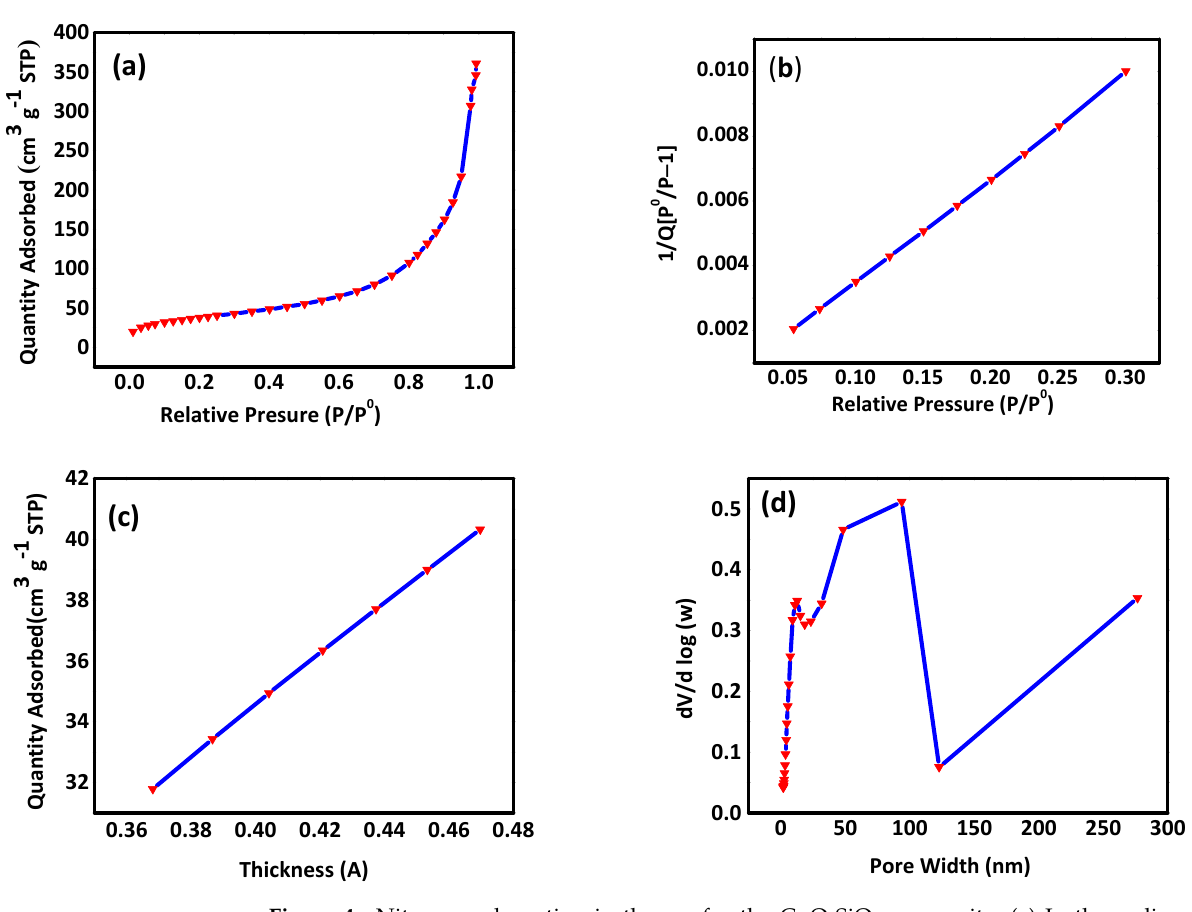
Figure 4. Nitrogen adsorption isotherms for the CuO-SiO 2 composite; ( a ) Isotherm linear plot ( b ) BET Surface area plot ( c ) t-plot and ( d ) BJH adsorption plot. At